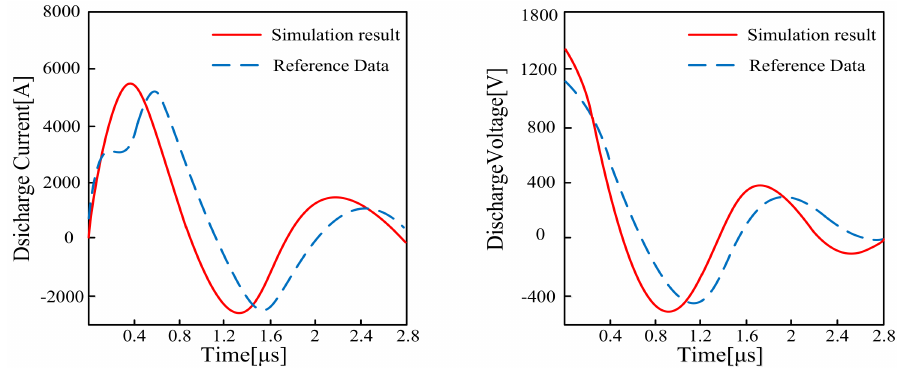
Figure 4. Comparison of discharge current and voltage waveforms between simulation results and reference data from Vondra [12,32].